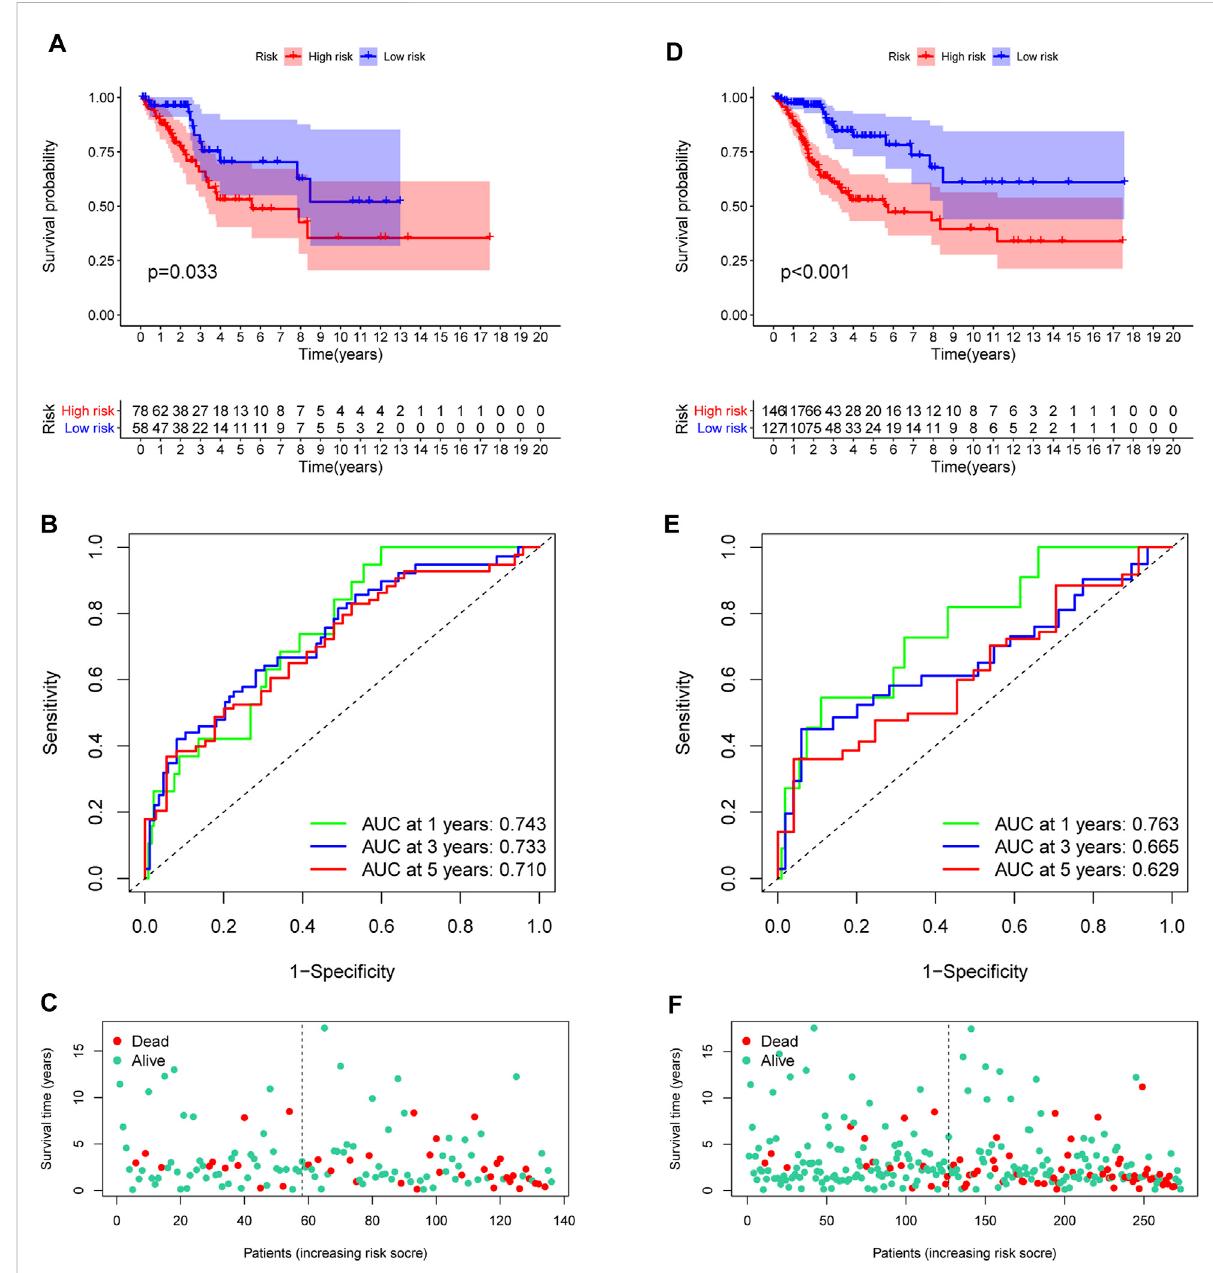
FIGURE 4 Validationoftheprognosticmodel. (A,D) Survivalanalysisinthetestandtheentirecohorts. (B,E) ROCcurvesoftheprognosticmodel. (C,F) The distribution of survival status in two veri fi cation